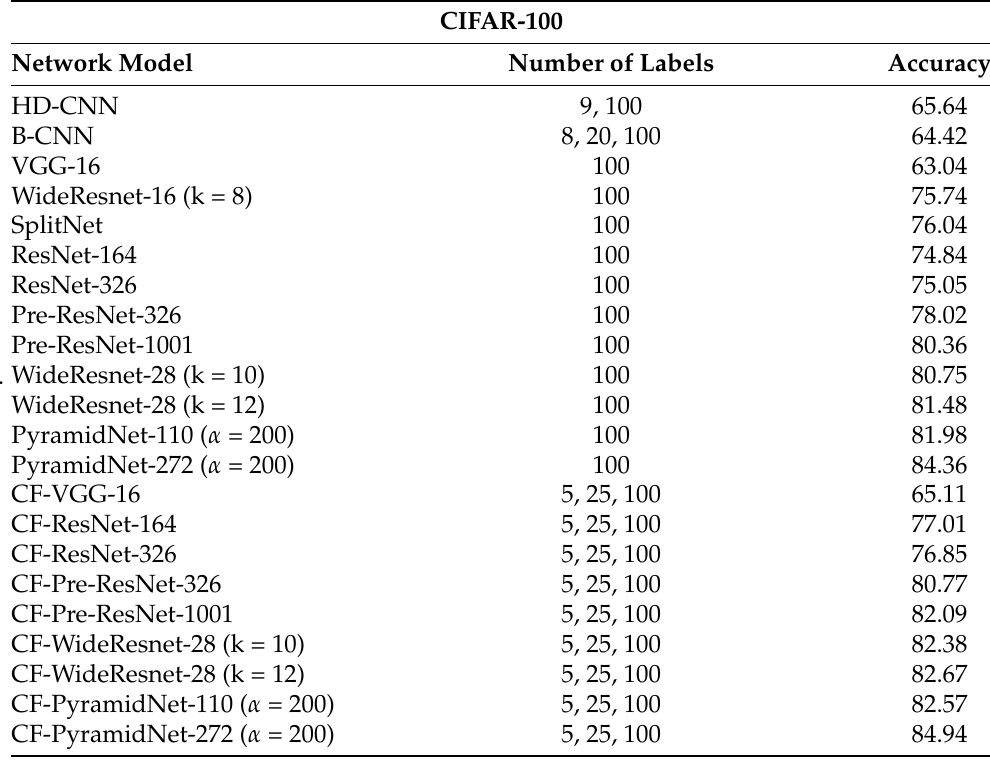
Table 9. Classification results using various classification models and grouping labels on the CIFAR- 100